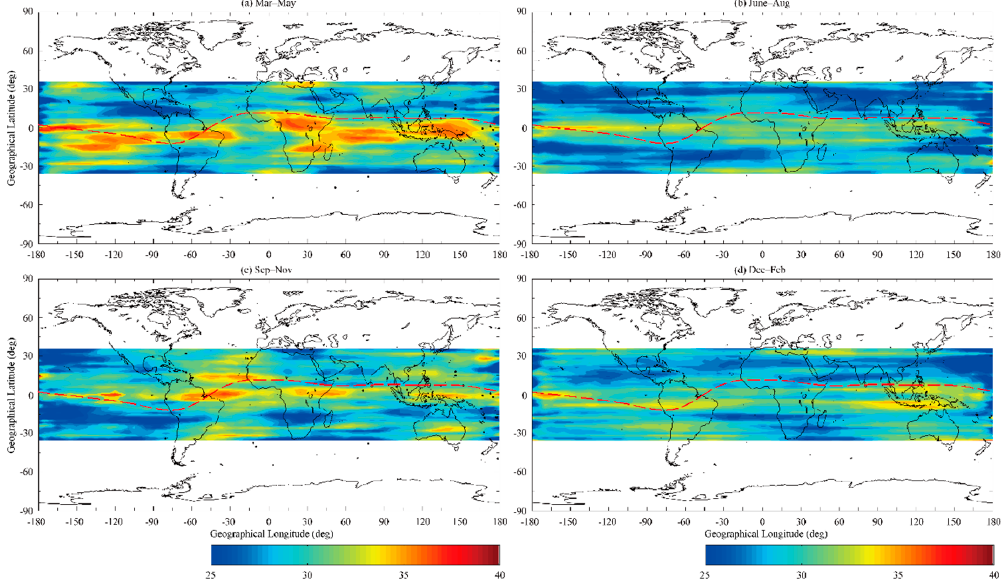
Figure 4. Occurrence rate of the nighttime (i.e., 18-06 LT) scintillation events in different seasons in 2017 binned within a 2° × 5° spatial resolution.